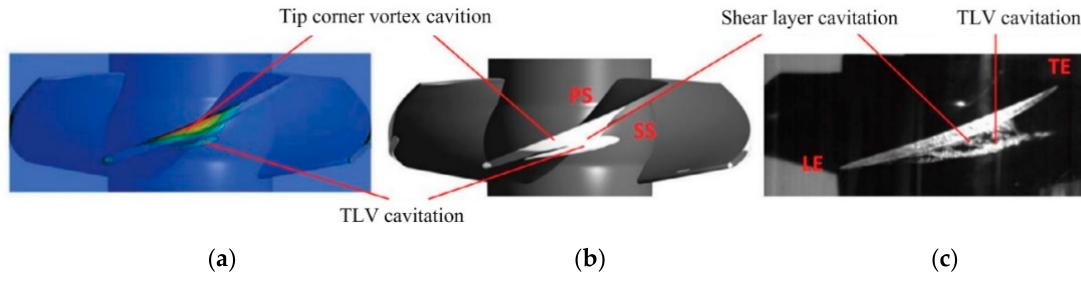
Figure 2. Tip leakage vortex (TLV) cavitation in an axial pump: ( a ) contours of vapor fraction in simulation; ( b ) isosurface of vapor fraction α v = 0.1 in simulation; ( c ) visualization of TLV cavitation in experiment [8]. PS: pressure side; SS: suction side; LE: leading edge; TE: trailing edge.